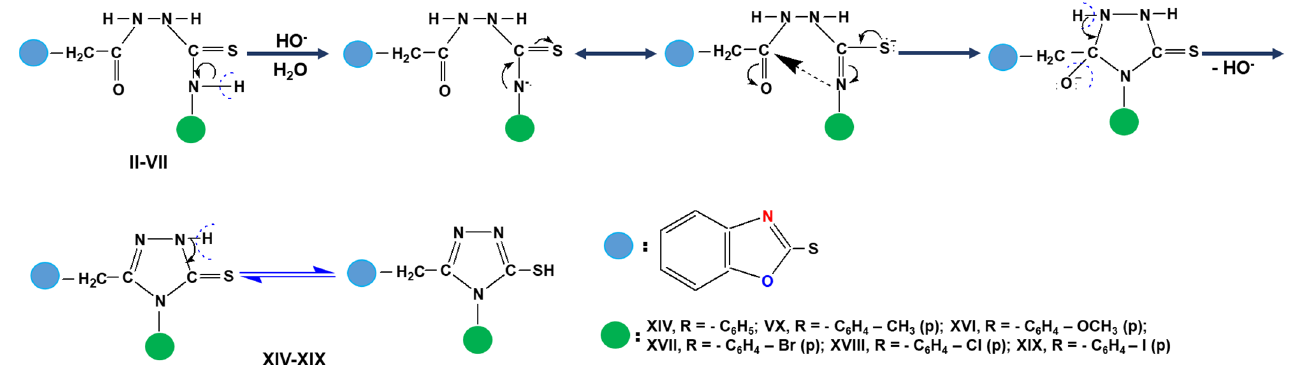
Figure 6. Cyclization mechanism of reaction synthesis of 5-mercapto-3,4-disubstituted-1,2,4-triazoles .